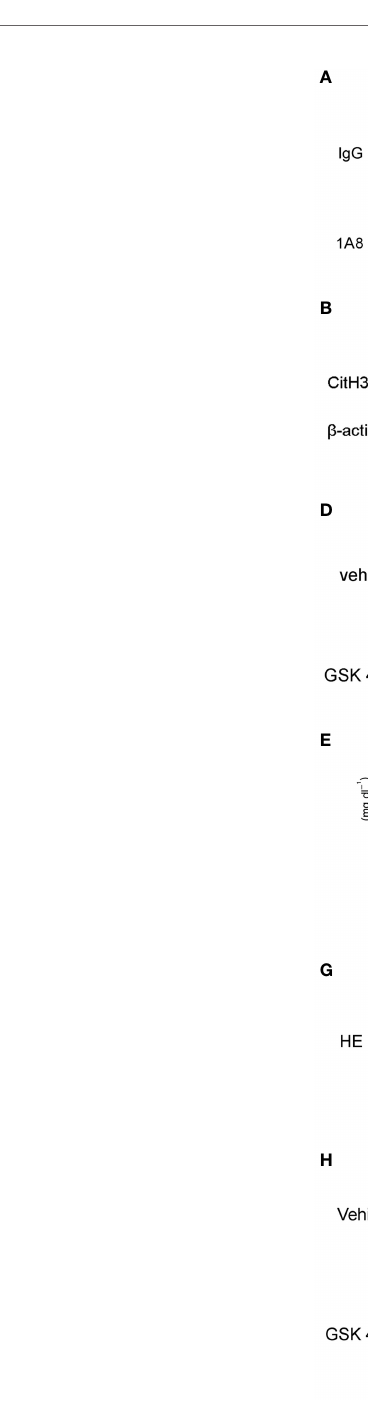
FIGURE 4 | NET formation decreased in renal tissue after neutrophils depletion. (A) Representative overlay images of NETs staining after neutrophil depletion by injection of 1A8 and control IgG mice 24 h after IRI. DAPI (blue), CitH3 (green), Ly6G (red). (B) Immunoblotting analysis of CitH3 expression in mouse kidneys 24 h after IRI. (C) Quantitative analysis was analyzed by normalization to b -actin expression, n = 3/group. (D) Representative NETs staining of bilateral IRI at different time points after reperfusion. Colocalization of CitH3 (green), MPO (red), and swelled nuclei (blue). (E) Serum creatinine, and (F) urea nitrogen of IRI mice injected with vehicle or GSK 484, n = 6/group. (G) Representative HE section of the kidney from mice in each group 24 h after IRI. Arrows denote tubules with necrosis and detachment. Asterisks indicate neutrophils in fi ltration. (H) Representative TUNEL staining images in kidney. *P < 0.05, **P < 0.01. N.S., No Signi fi cance. Data are presented as mean ±